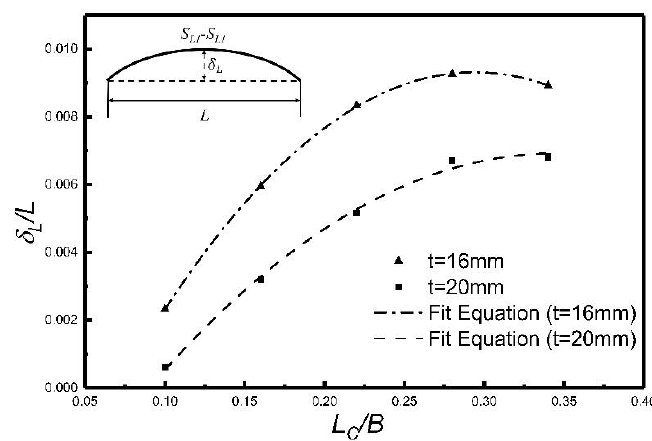
Figure 13. Effect of coil width on the longitudinal bending deflection.